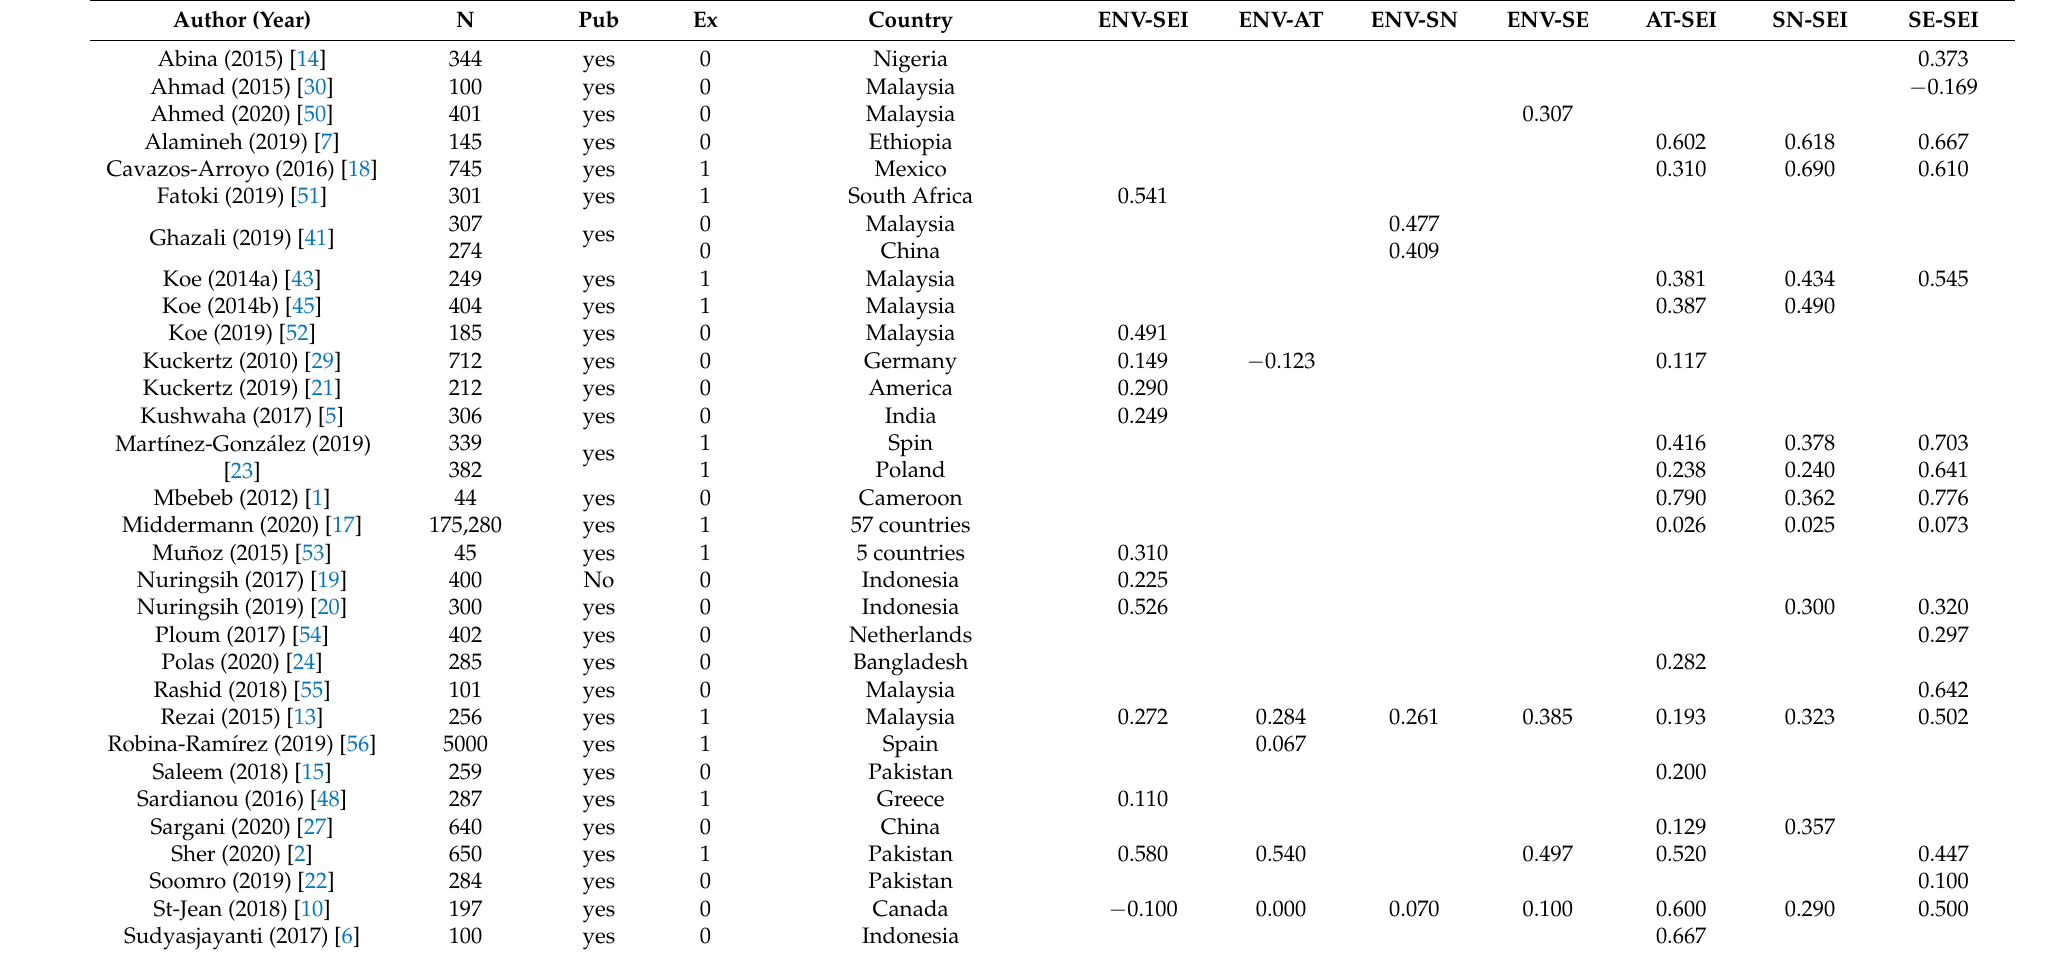
Table A1. Overview of studies included in the